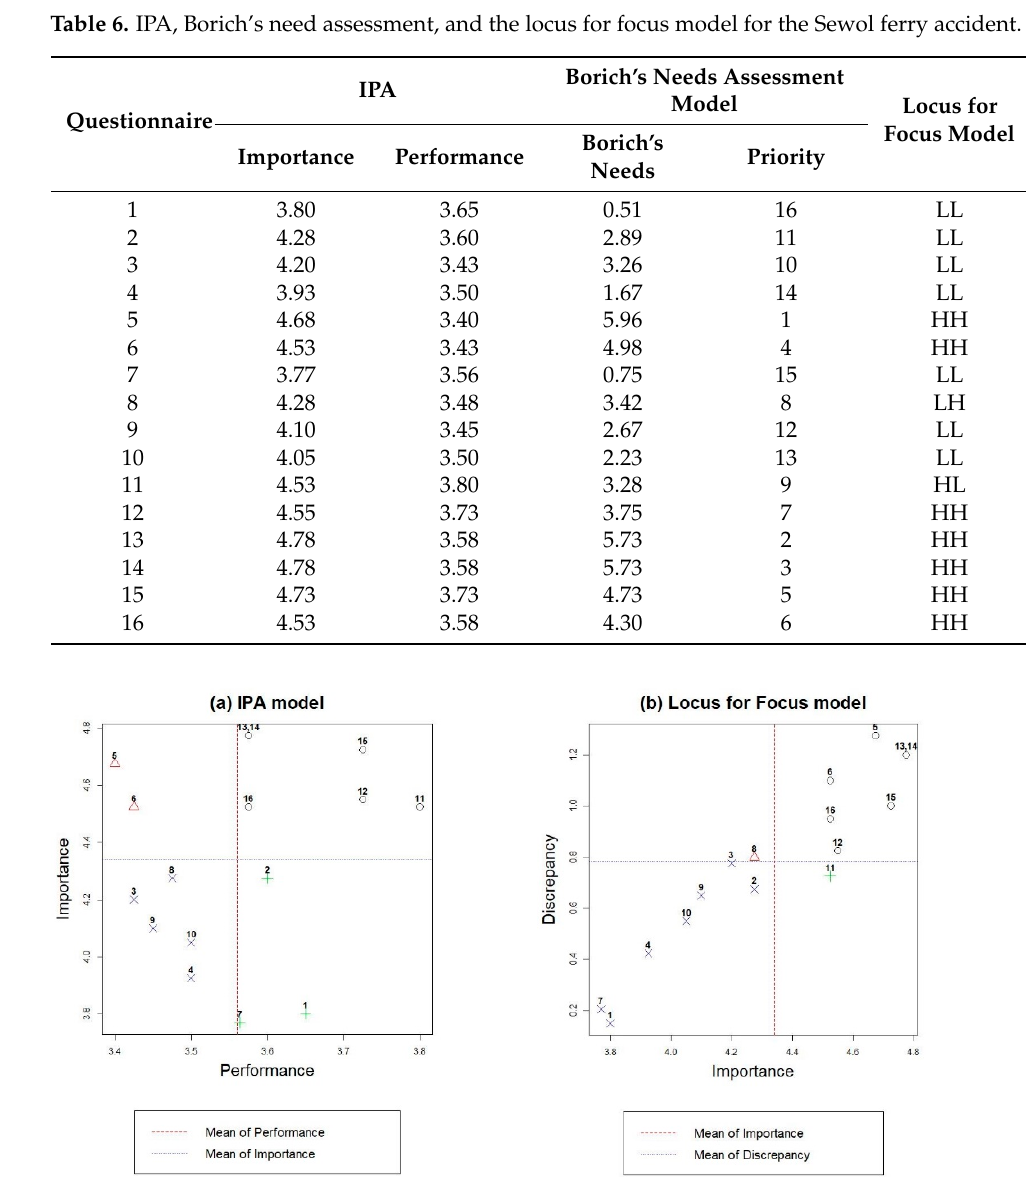
Figure 5. Analysis of the Sewol ferry accident from the provided articles using: ( a ) IPA model; ( b ) locus for focus model.